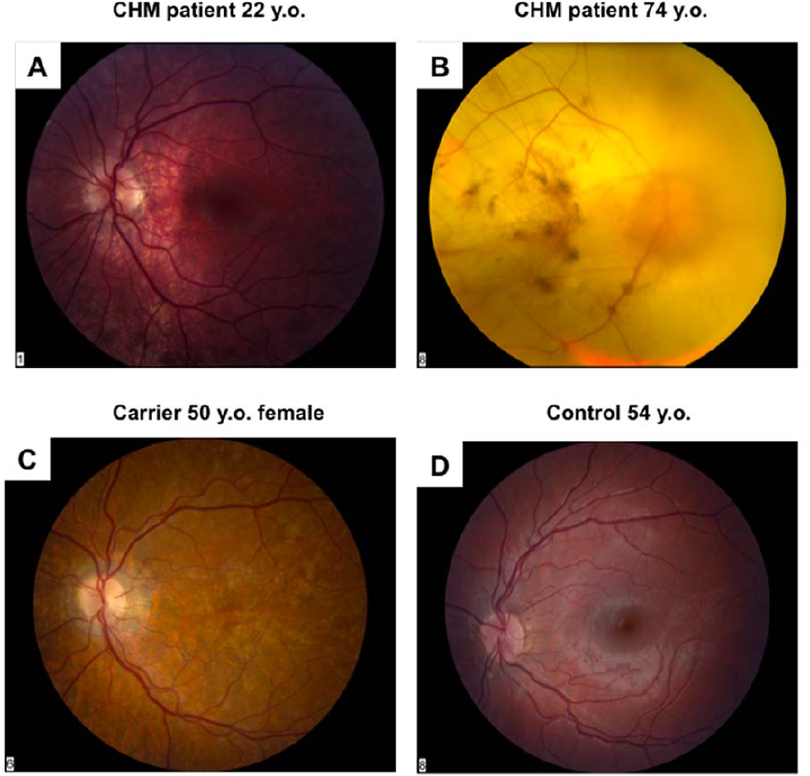
Figure 2. Fundus photographs of the control and CHM patients. a. CHM patient 22 y.o. characterized by RPE depigmentation and widespread RPE disruption b. CHM patient 74 y.o. characterized by loss of RPE and choroid, scattered pigment in macula, faint deep choroidal vessels and severely narrowed retinal vessels and optic nerve pallor ( Table 1 , CHM 9 and 10 respectively). c. Female CHM carrier, age 50 showing patchy RPE hypopigmentation without pigment dispersion and control subject. d. Fundus photograph of the normal